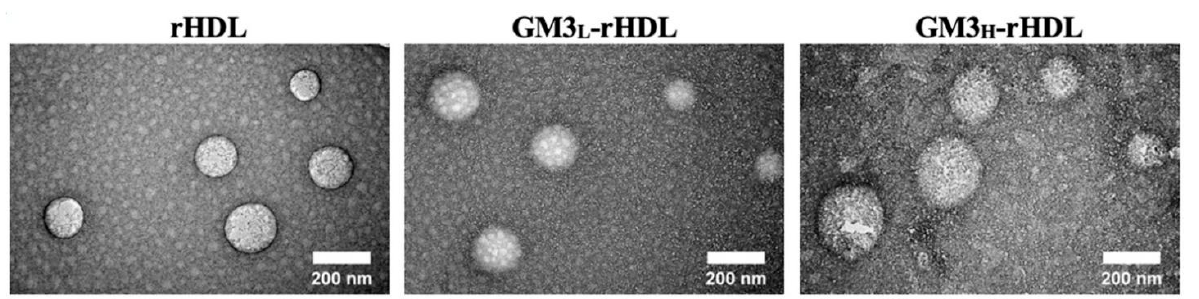
Figure 1. TEM images of rHDL, GM3 L -rHDL, and GM3 H -rHDL nanoparticles, respectively.